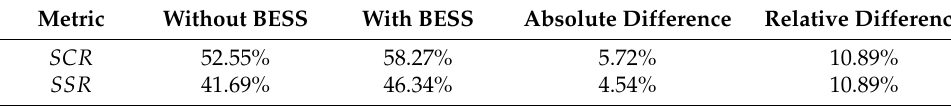
Table 16. Evaluation of the prosumer’s energy balance during May